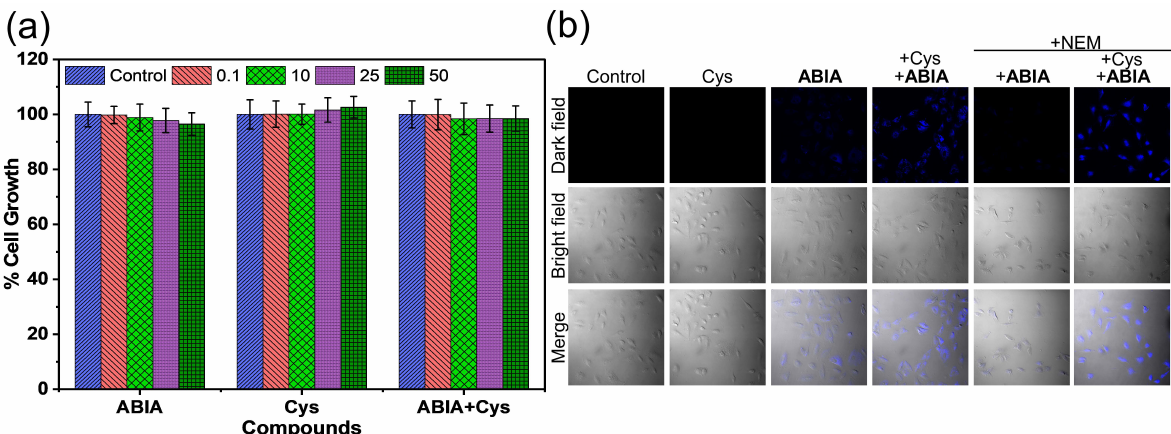
Figure 7. ( a ) Cytotoxicity’s of ABIA , Cys, and ABIA + Cys on A549 cells at concentrations of 0.1, 10, 25, and 50 µ M after 24 h; ( b ) Dark field, bright field, and merged images upon treatment of A549 cells with control, Cys, ABIA , Cys + ABIA , NEM + ABIA , and NEM + Cys + ABIA